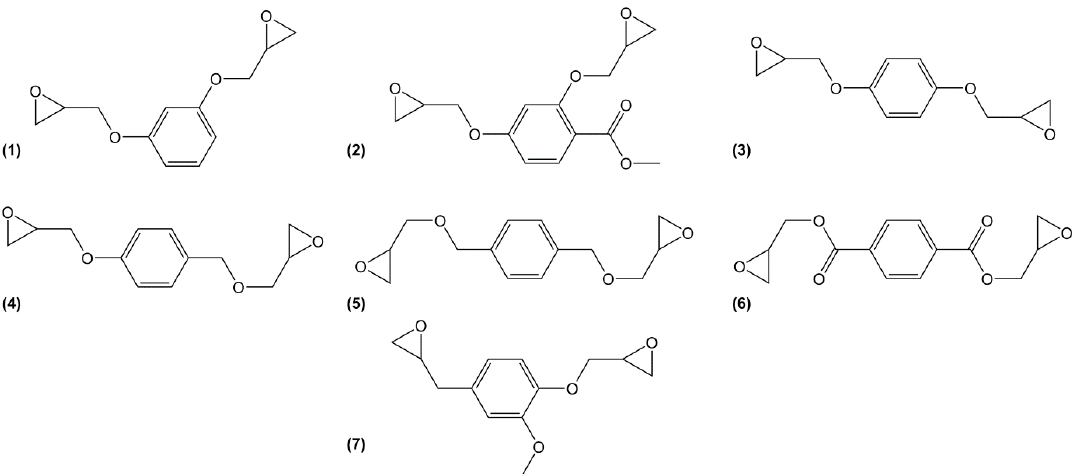
Figure 11. Mono-aromatic phenyl-based di-functional epoxy compounds.